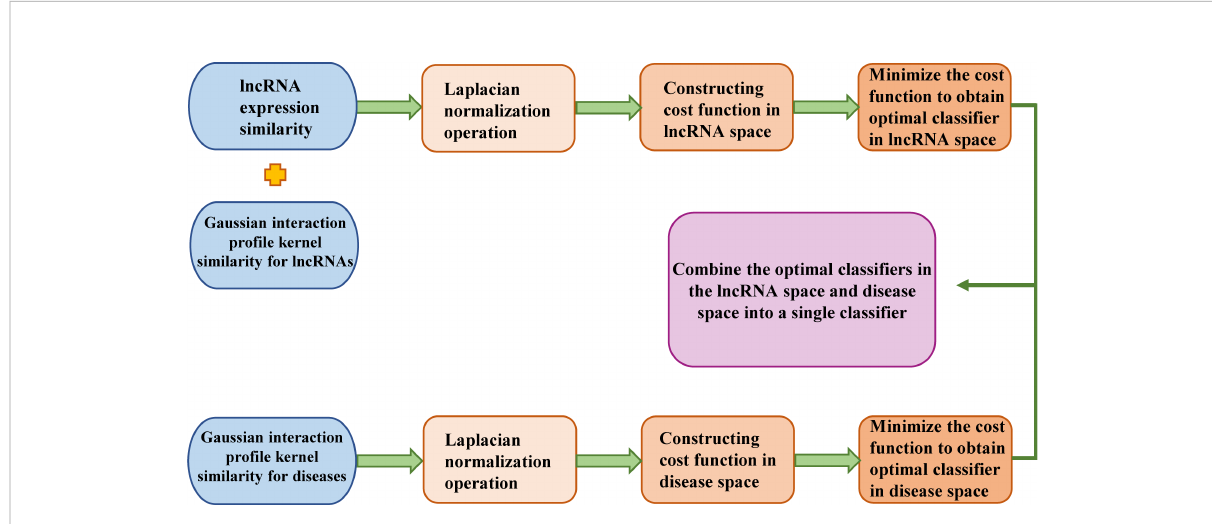
FIGURE 2 The fl owchart of LRLSLDA is shown here, including the basic steps to predict potential disease-related lncRNAs based on